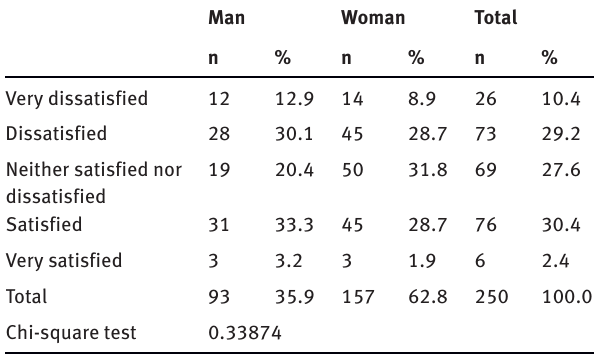
Table 6: Answers to general WHOQOL questions (quality of life assessment) divided by sex